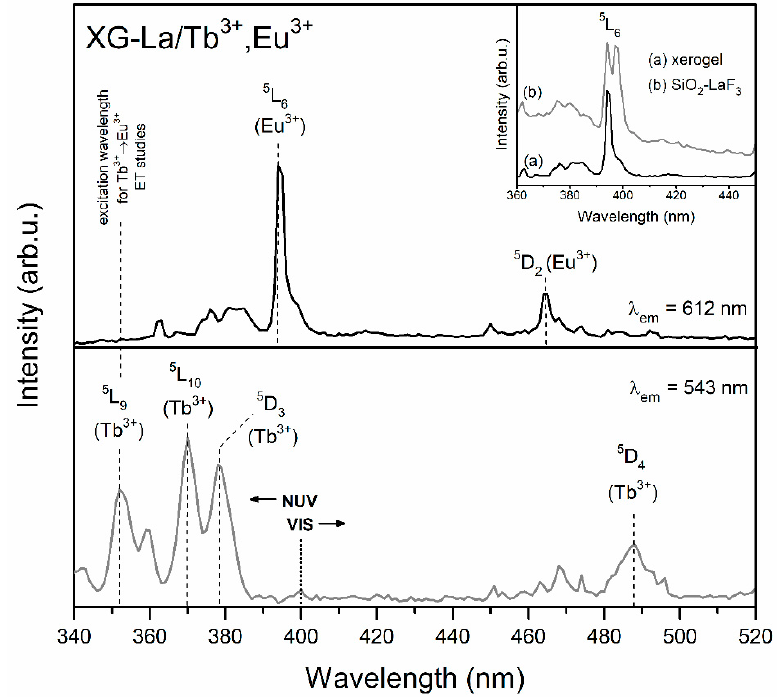
Figure 3. PLE spectra of XG-La / Tb 3 + ,Eu 3 + co-doped sample, monitored at λ em = 543 nm and λ em = 612 nm.